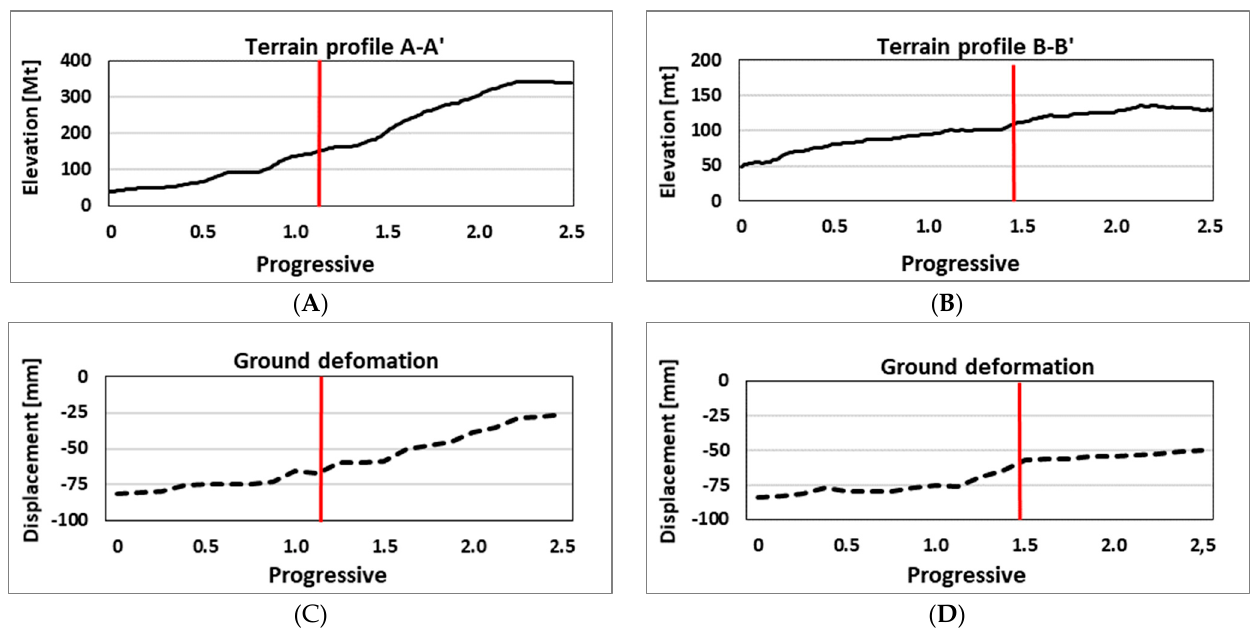
Figure 14. Profile lines are perpendicular to Fault 1 and Fault 3. Figures ( A ) and ( B ) show the terrain profile (A-A’, B-B’), and ( C ) and ( D ) show the estimated ground deformation obtained with MT-InSAR.